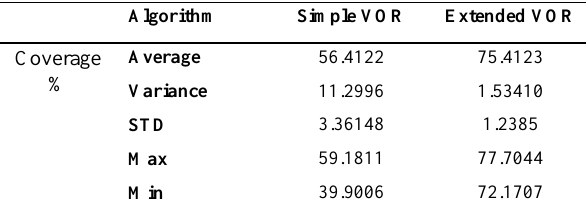
Table 1. Comparison of simple and extended VOR algorithm